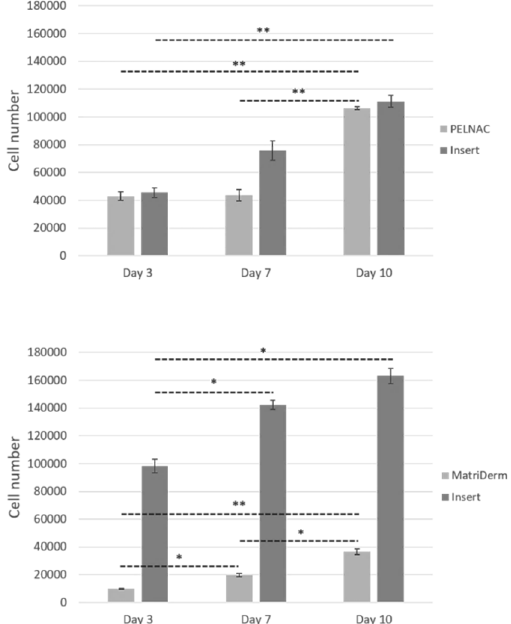
Figure 7. Cell proliferation by Alamar Blue assay. Results show average ± standard error of mean ( n = 4). * p < 0.05. ** p <